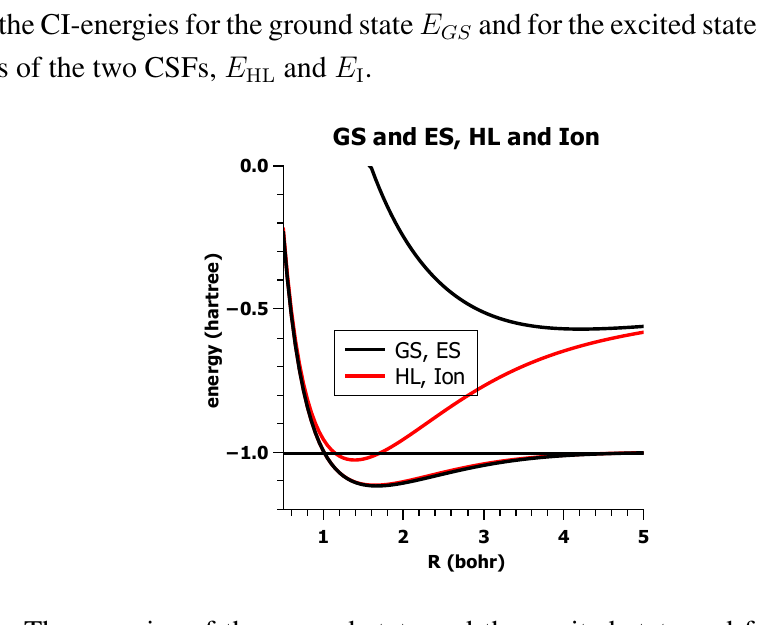
Figure 19. The energies of the ground state and the excited state and for the HL and the ionic CSF. Energy in Hartrees; bond length in